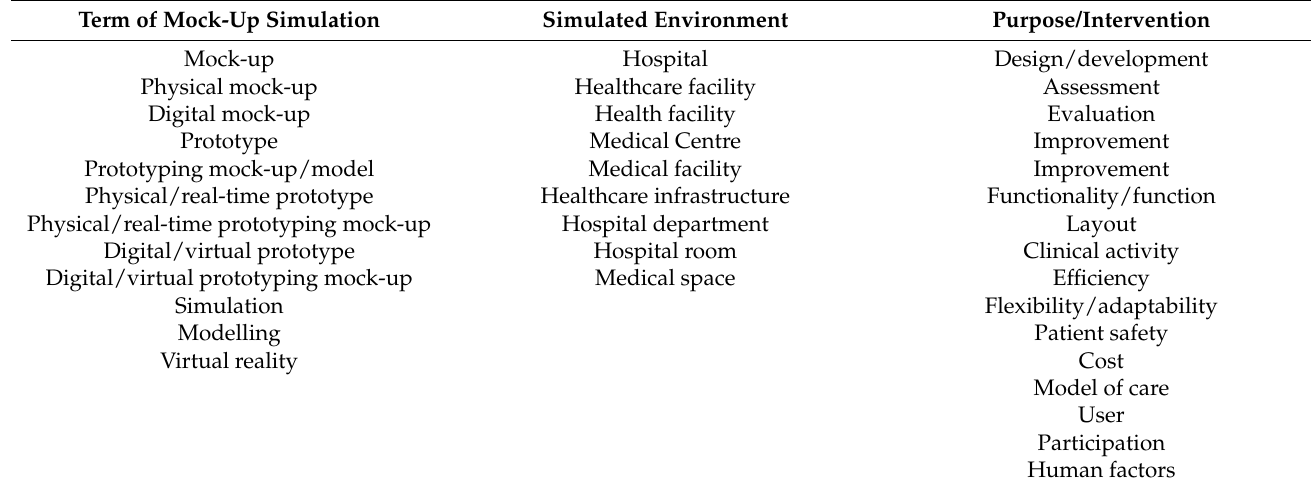
Table 1. Keywords used in literature